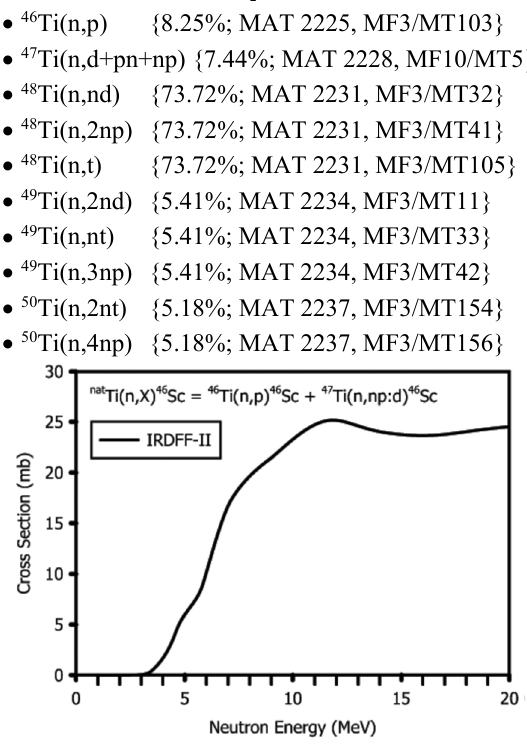
Fig. 1. nat Ti(n,X) 46 Sc cross section (normalized per elemental Ti atom) [4]